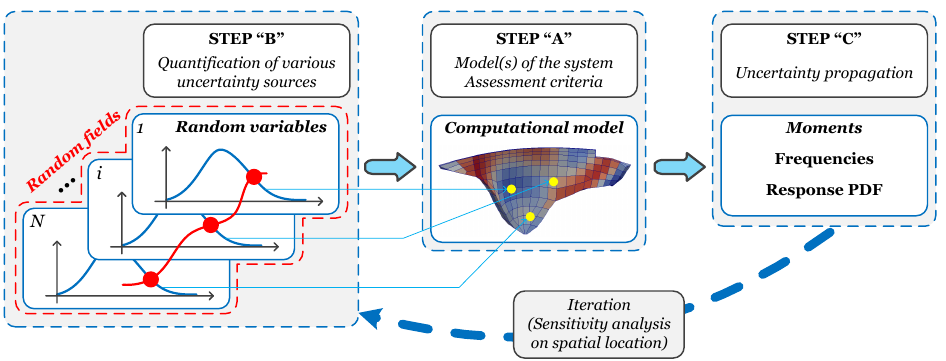
Figure 2. A framework for uncertainty quantification with random fields; adapted from Reference [40] and